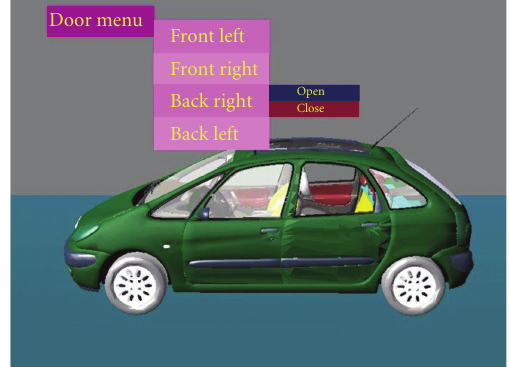
Figure 2: Decoupled menu structure.